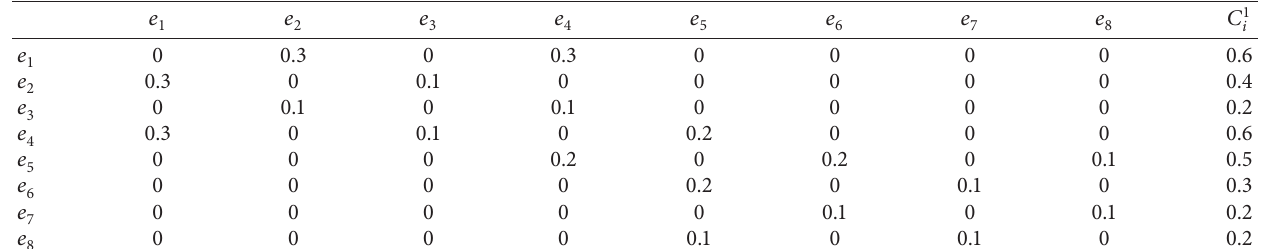
) and Z ∗ ( e ) 1 2 ) with choice values. 1